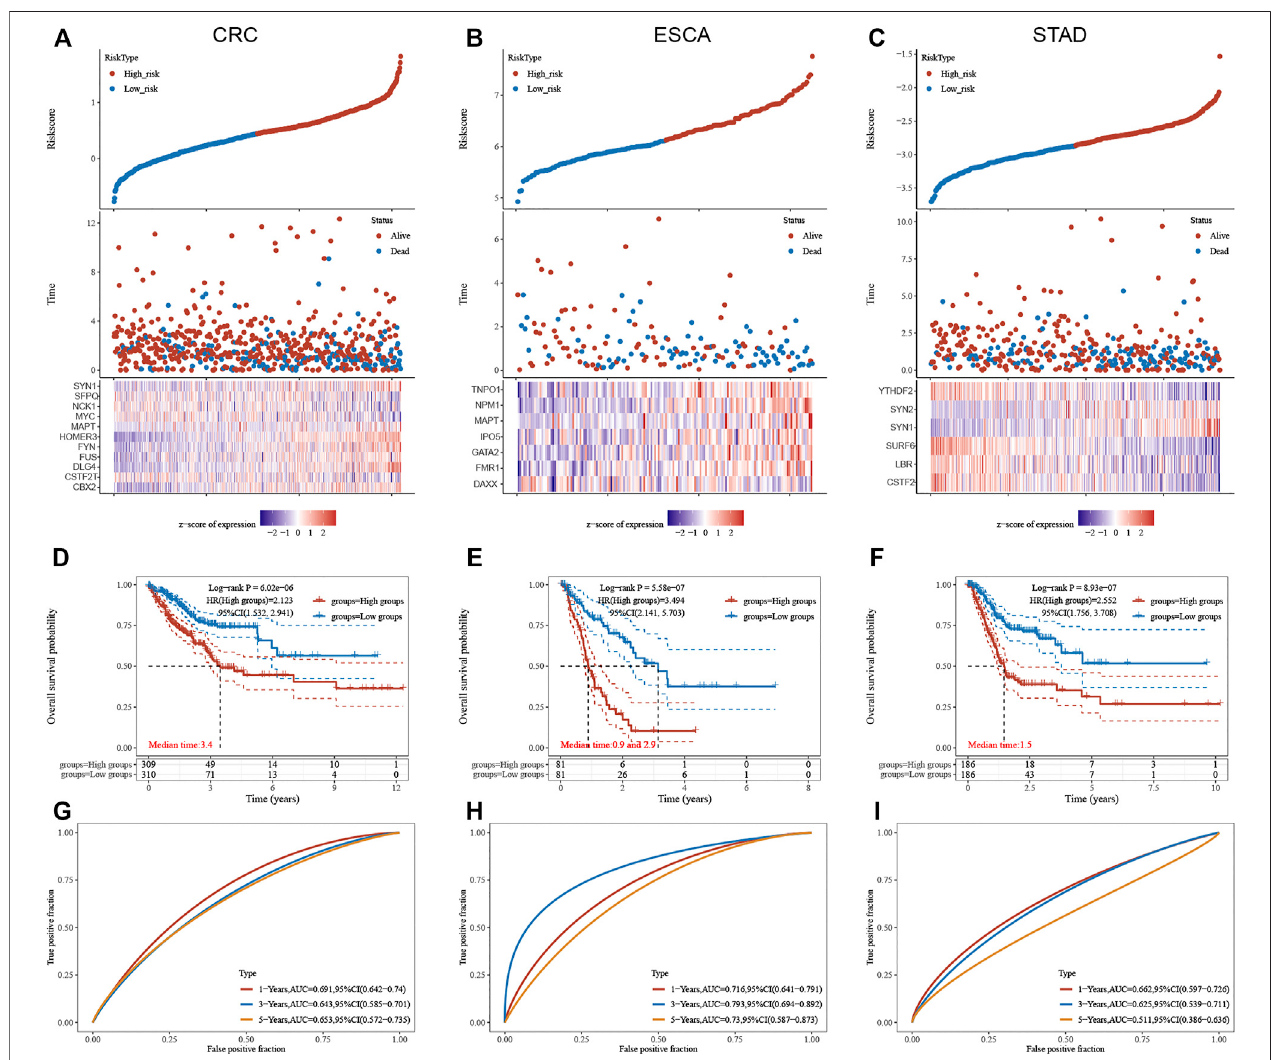
FIGURE 7 | Construction of LLPS regulators signature in digestive system neoplasms. (A – C) LASSO regression identi fi ed the most signi fi cant prognosis-related genes in CRC (A) , ESCA (B), and STAD (C) . (D – F) Our results showed that the OS was remarkedly shorter in the high-risk group than that in the low-risk group in CRC (D) , ESCA (E) , and STAD (F) . (G – I) Time-dependent ROC analysis of established score in CRC (G) , ESCA (H) , and STAD (I) .